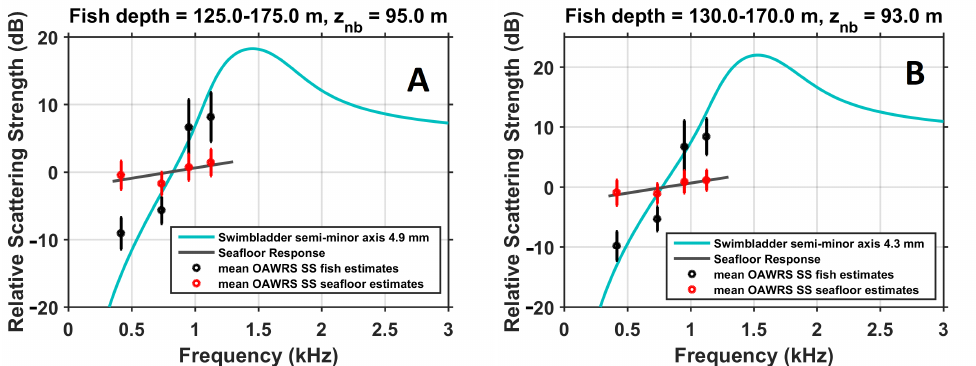
Figure 7. Relative scattering strength versus frequency for fish and seafloor after subtracting instanta- neous average scattering strength over frequency at each pixel comprising different relative spectral